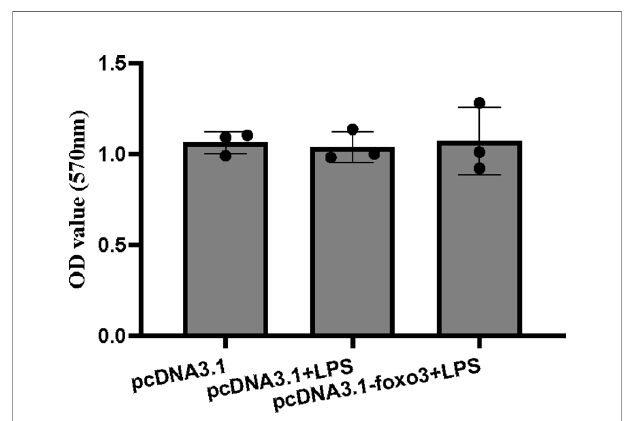
FIGURE 8 | The OD values of MTT. Results are represented as mean ± standard deviation (n = 3). Values with different letters mean signi fi cant differences ( P <